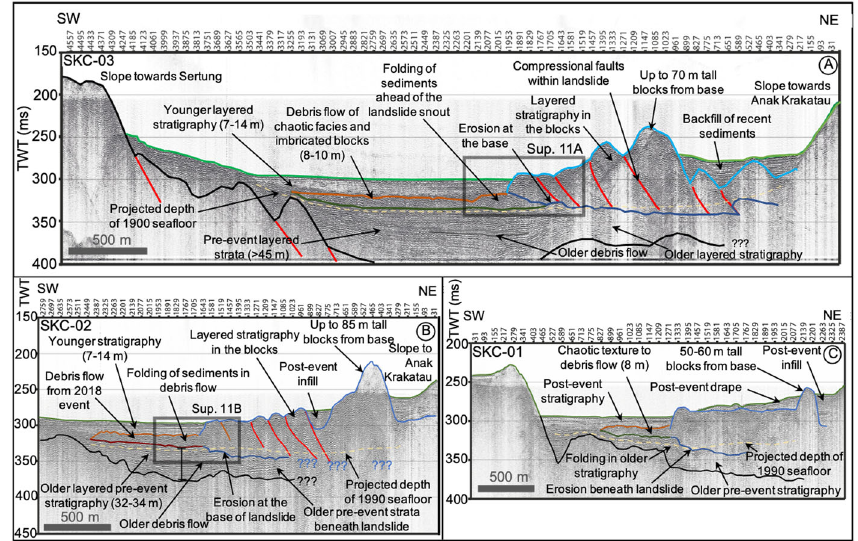
Fig. 7 Downslope seismic re fl ection SPARKER pro fi les collected post-collapse in August 2019. Pro fi les SKC-03 ( A ), SKC-02 ( B ) and SKC-01 ( C ) show the emplacement of a large landslide mass on the sea fl oor and its incision into the sea fl oor. Also shown is the presence of a secondary debris fl ow projecting into the basin from the toe of the landslide, which has been subsequently buried by excessive post-collapse sedimentation of eruptive materials. Also shown is the projected two-way travel-time-converted level of the 1990 sea fl oor (based on Deplus et al. 11 bathymetry) to demark the sedimentation in the basin since that time. The green horizon represents the sea fl oor; pale blue represents the top of the landslide blocks; dark blue represents the base of the landslide blocks; pale and dark brown represents the top and base of the buried debris fl ows, respectively; pale and dark grey represents the top and base of older buried debris fl ows; and red represents potential faults. Insets represent magni fi ed images of the toe of the landslide and debris fl ow and are represented in Supplementary Fig.